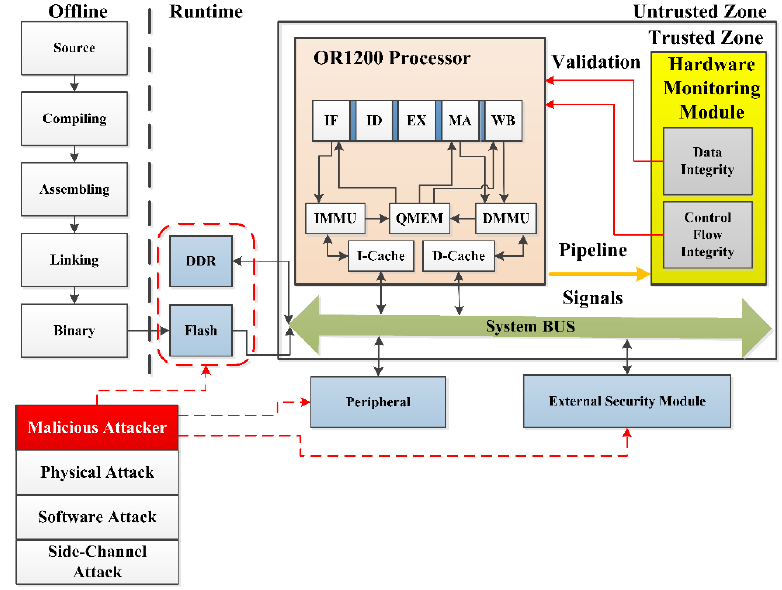
Figure 2. Threat model of the proposed work.